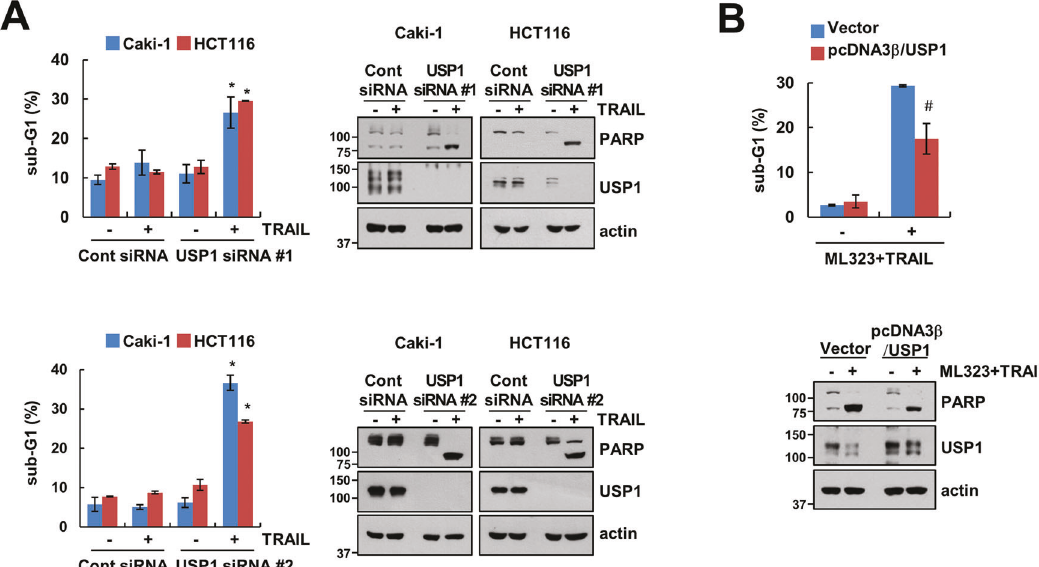
Fig. 7 Depletion of USP1 contributes TRAIL sensitization. A Caki-1 and HCT116 cells were transfected with control siRNA or USP1 siRNA followed by 50 ng/mL TRAIL for 24 h. B Caki-1 cells were transfected with vector or pcDNA3 β -USP1 followed by combination of 30 μ M ML323 and 50 ng/mL TRAIL for 24 h. The sub-G1 population and protein expression were determined using fl ow cytometry and western blotting, respectively ( A , B ). Values in the graphs ( A , B ) represent the mean ± SD of three independent experiments. * P < 0.01 compared to TRAIL- treated control siRNA-transfected group. # P < 0.01 compared to combinations of ML323 and TRAIL-treated pcDNA3 β -USP1-transfected